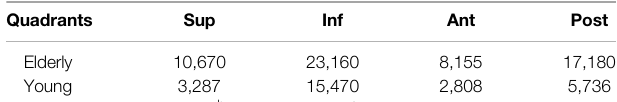
TABLE8| TheminimumprincipalstrainandmeanSEDofosteocytesintheelderly and the young. Absolute values of the minimum principal strain at cell scale ( μ ε )